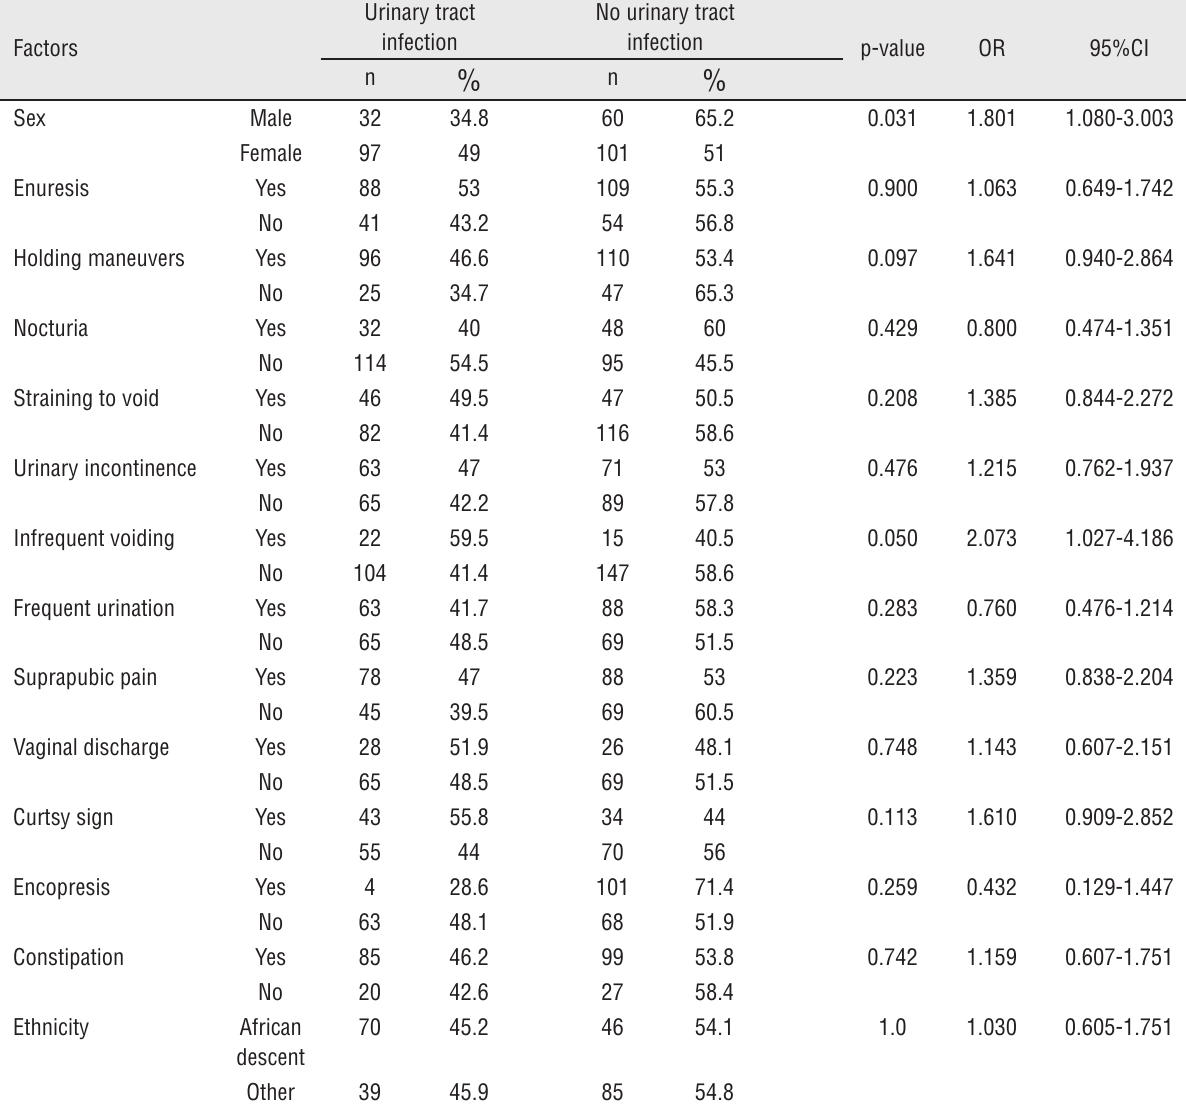
Table 2 - Factors associated with febrile urinary tract infection in patients with overactive bladder: univariate analysis.